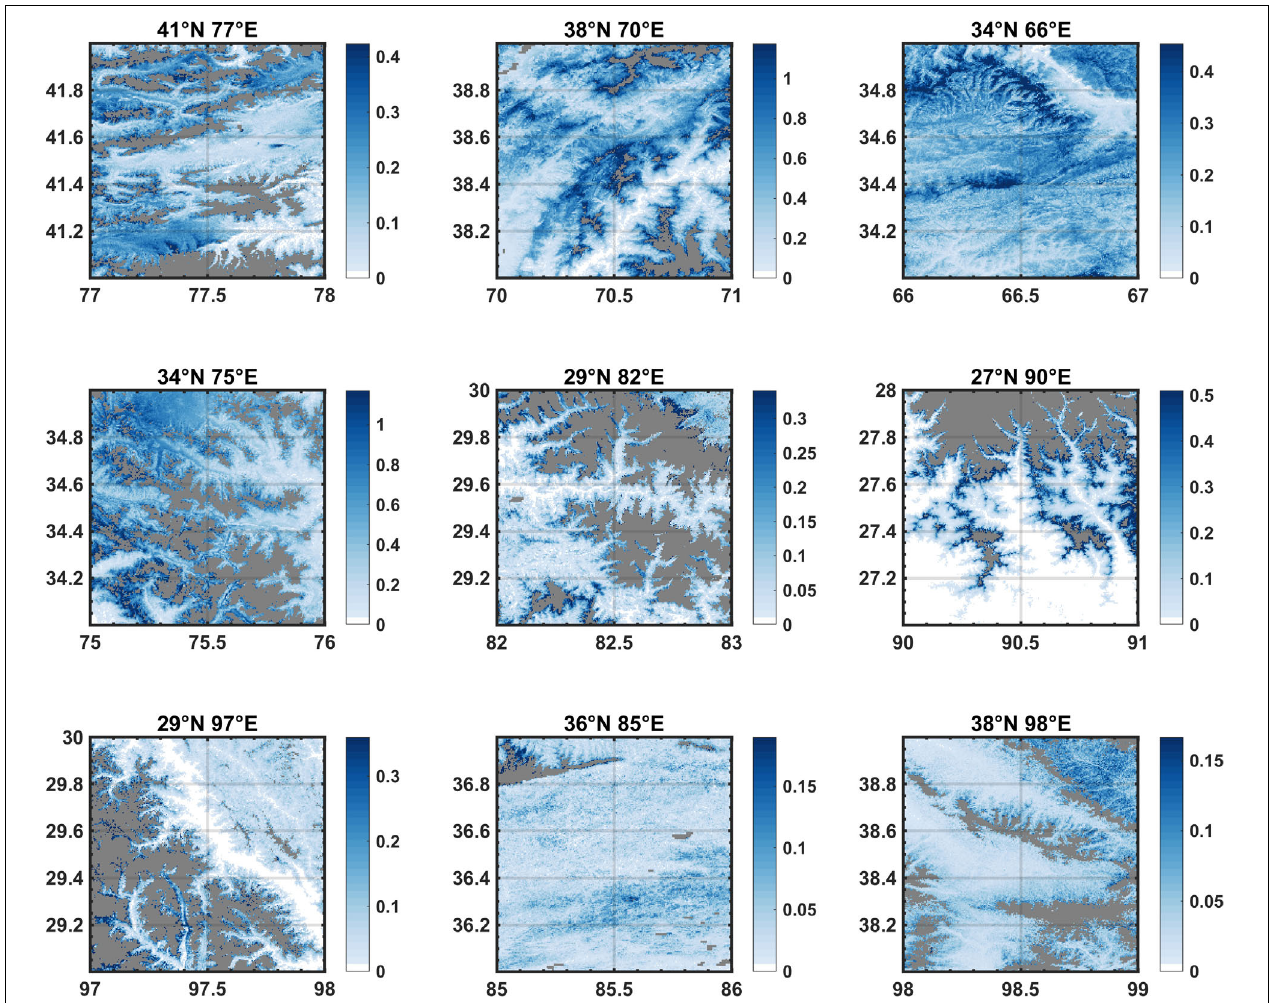
FIGURE 11 | Maps of climatological (i.e., averaged over WYs 2000–2017) pixel-wise peak SWE (in meters) for the set of HMA test tiles. The gray pixels represent those masked out as pre-identified glaciers, likely glaciers (i.e., pixels with persistent carry-over SWE in more than 14 out of 18 years), or open water bodies. For reference, the tile DEMs are shown in Figure 1 . The upper value used in the colorbars represent the 95th percentile of values in each map and not the maximum